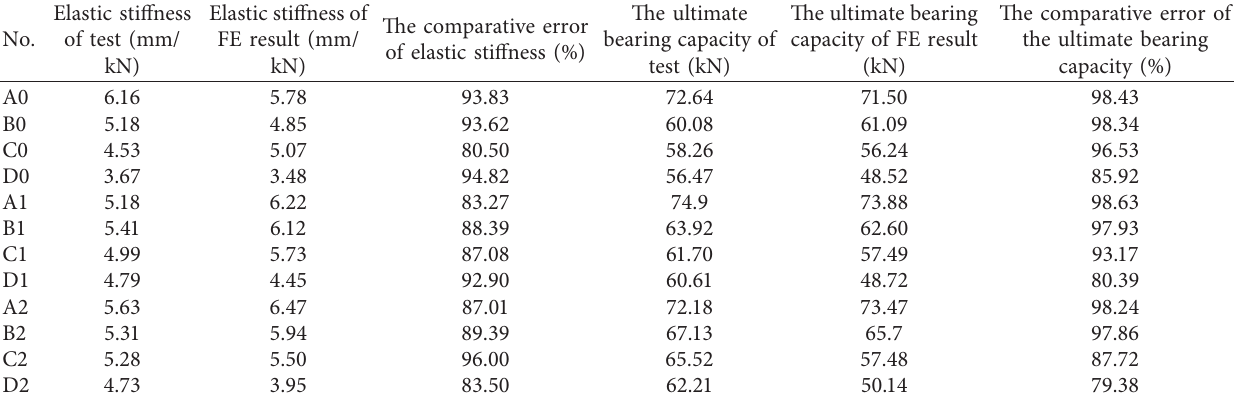
Table 5: Comparative error analysis of test and finite element skeleton curves.